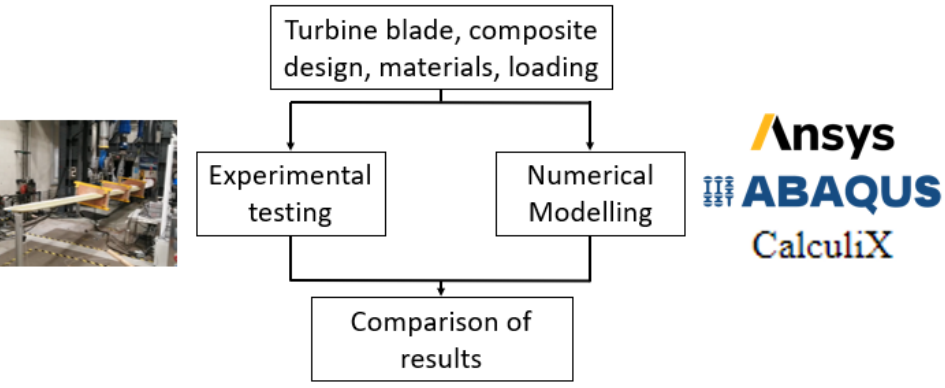
Figure 1. Methodology for fairly comparing the 3 numerical models that are developed in this study. Note: A larger version of the experimental testing image is shown in Figure 5.